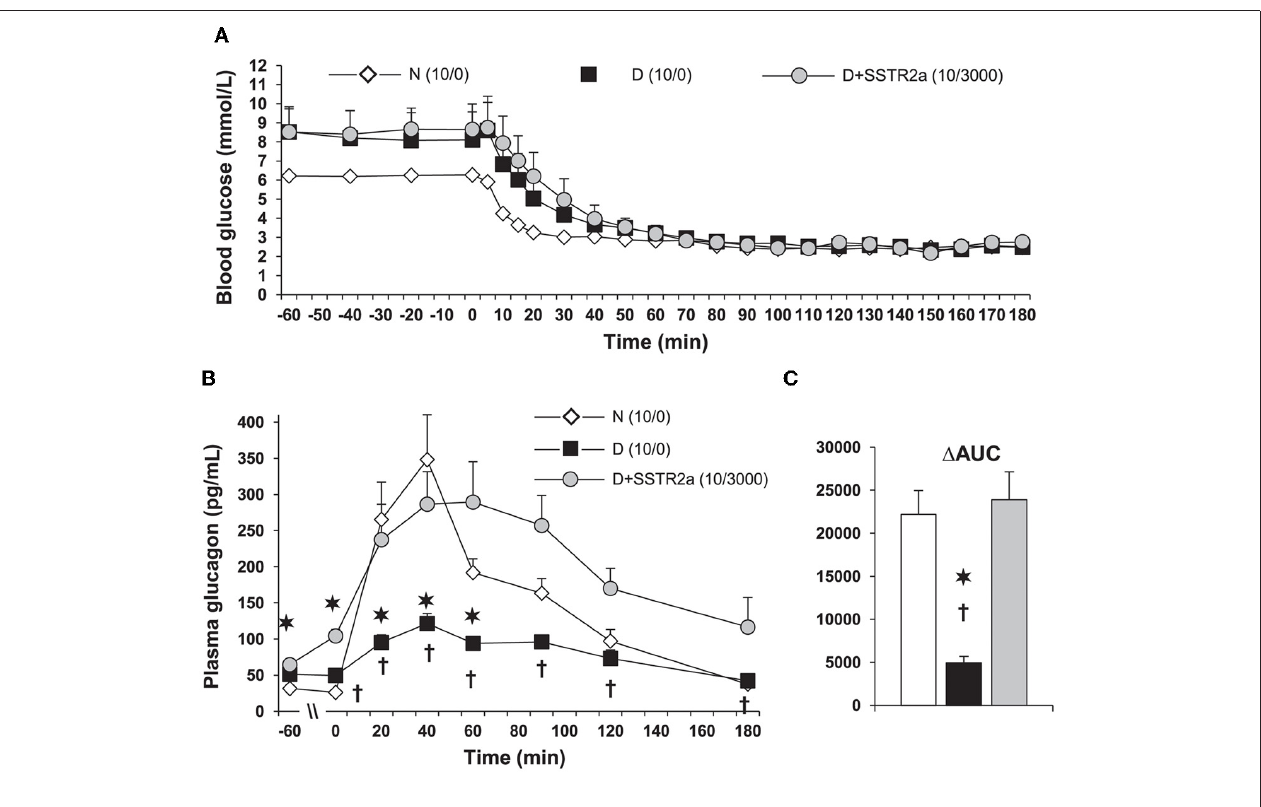
same as in normal (N) rats. (C) The data is also shown as area under the curve (AUC) analysis. The data is modified from that we reported in ref. Yue et al. (2011). The SSTR2a is highly specific for glucagon and only marginally for insulin, and it’s structure is H-Fpa-cyclo[DCys-PAL-DTrp-Lys- Tle-Cys]-Nal-NH2 (Yue et al., 2011). ∗ P < 0 . 002D vs. N; † P < 0 . 05D vs. D +